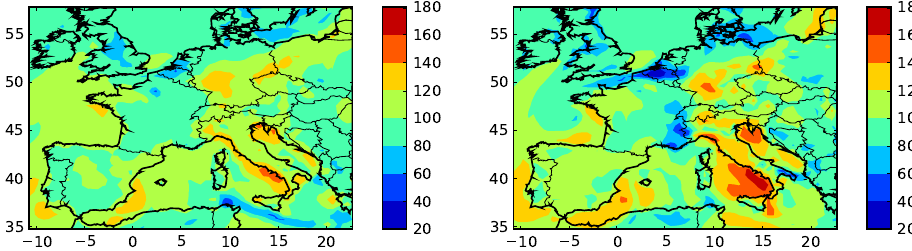
Fig. 6. Ozone map of model 98 (left) and model 58 (right), on 5 May 2001 at 17:00 UT. Both models show good performance, but they can produce ozone fields that differ significantly.